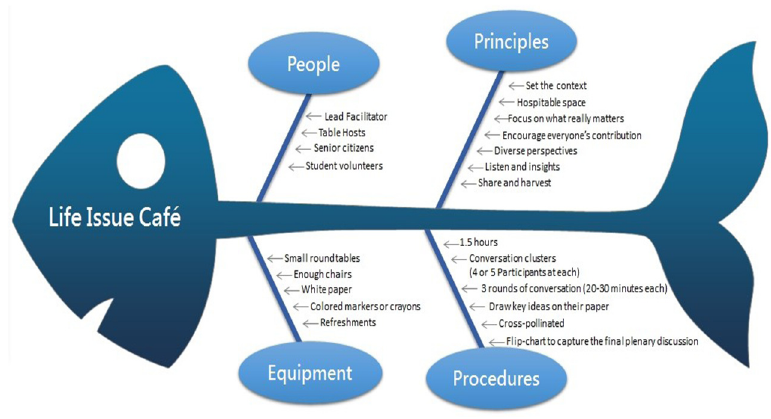
Figure 2. Method of Life Issue Café.